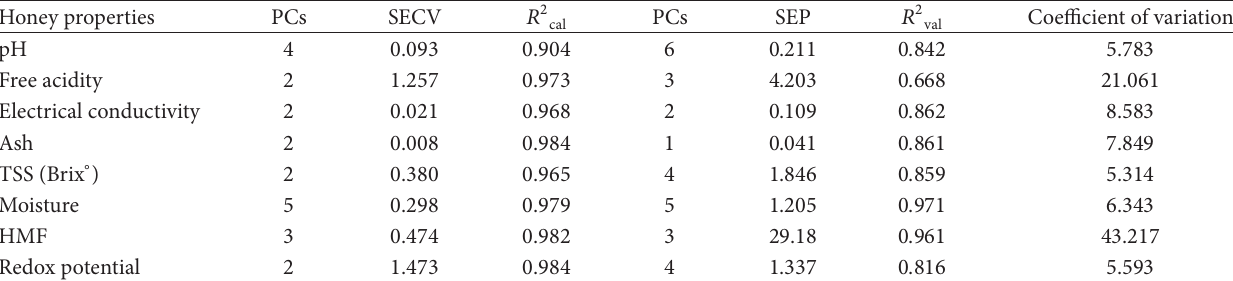
Table 2: Statistical parameters obtained for each of the calibration models.